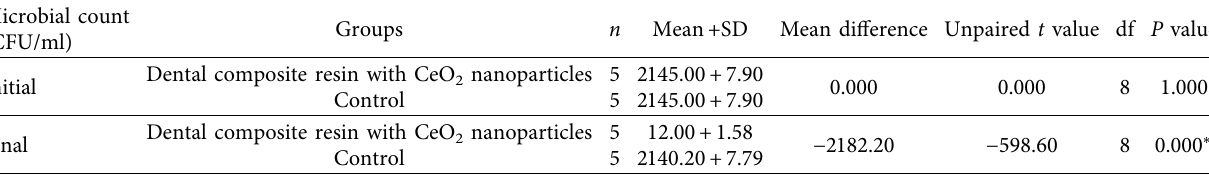
Table 3: Comparison of microbial count (CFU/ml) between the experimental group and control group for Streptococcus mitis . Microbial count (CFU/ml)